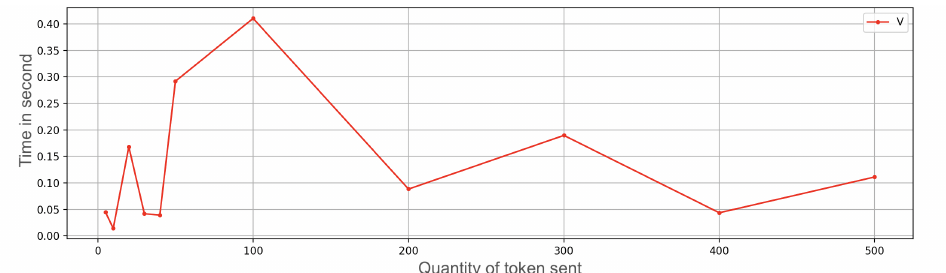
Figure 7. Exchange token time on iPhone 7 with secure enclave execution measuring average (A) of ramp test.